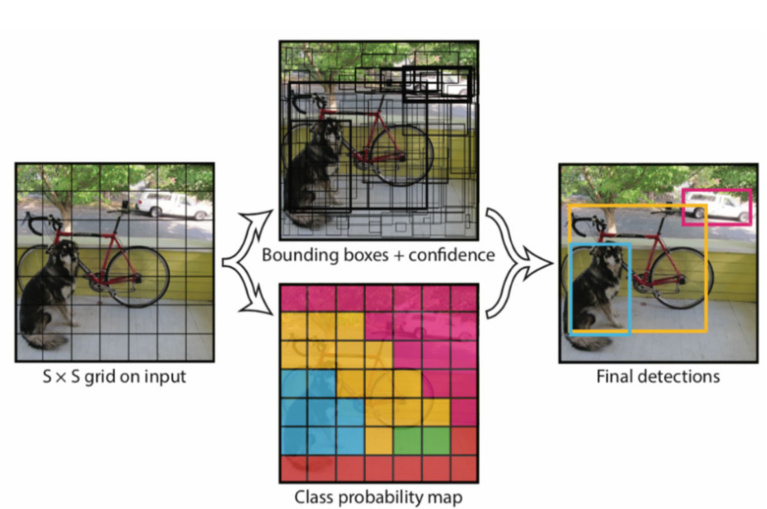
Figure 3. Object detection processing process of YOLO